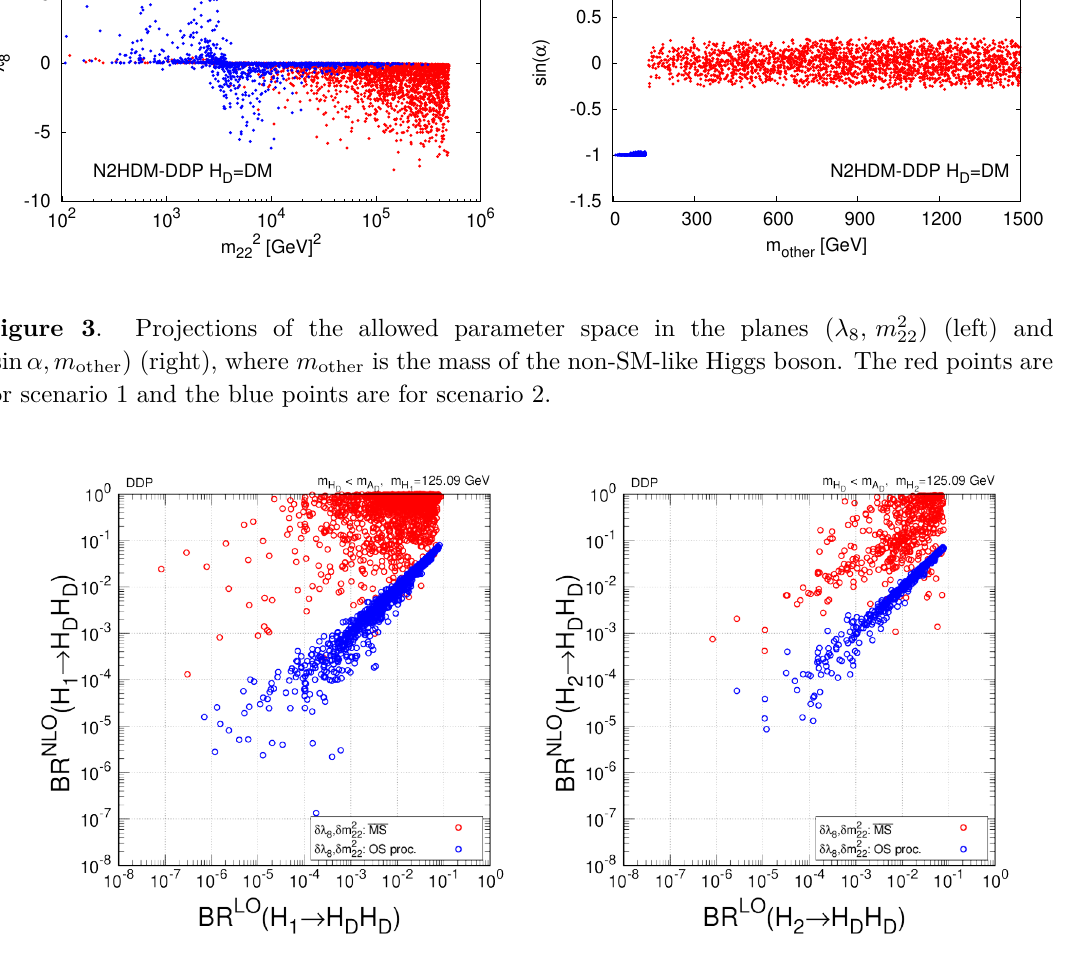
Figure 4 . Correlation between the branching ratios at NLO and at LO in scenario 1 (left) and scenario 2 (right), respectively. The red and blue points correspond to results in the MS scheme and in the OS process-dependent scheme,